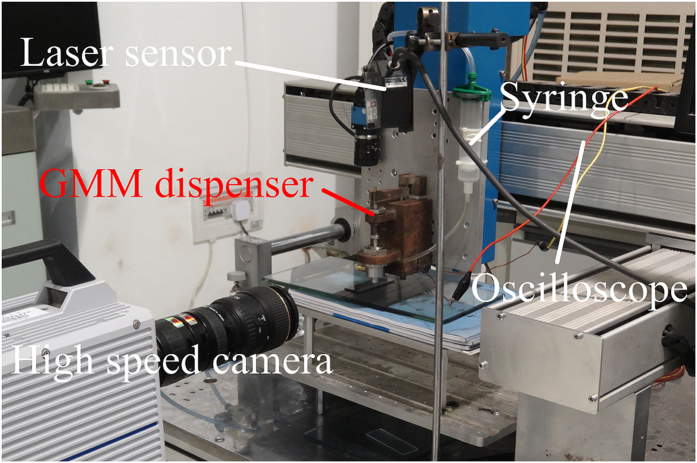
Experimental bed.